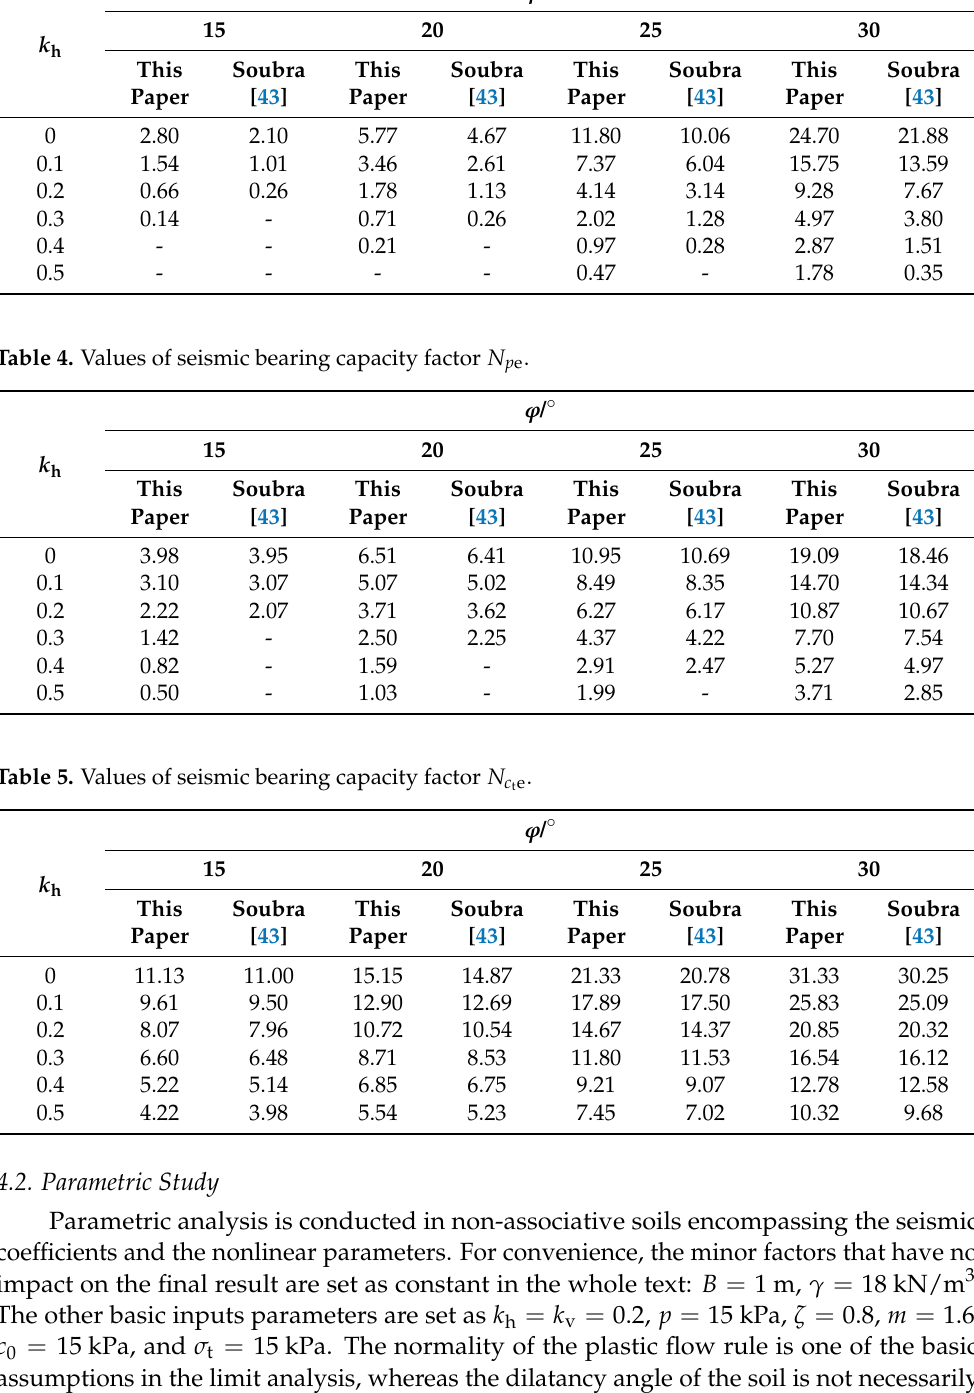
Table 3. Values of seismic bearing capacity factor N γ e .